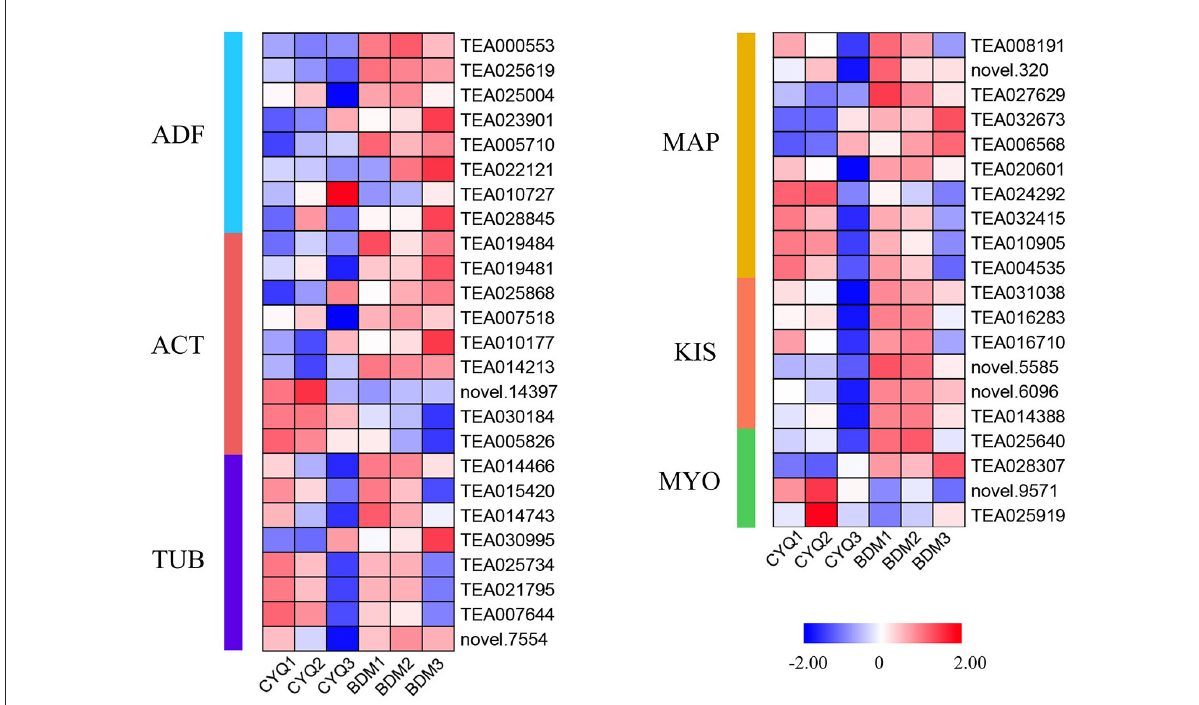
FIGURE10 The expression pattern of cytoskeleton biosynthesis related genes. DEGs related to cytoskeleton biosynthesis. The expression levels of DEGs were normalized by log 2